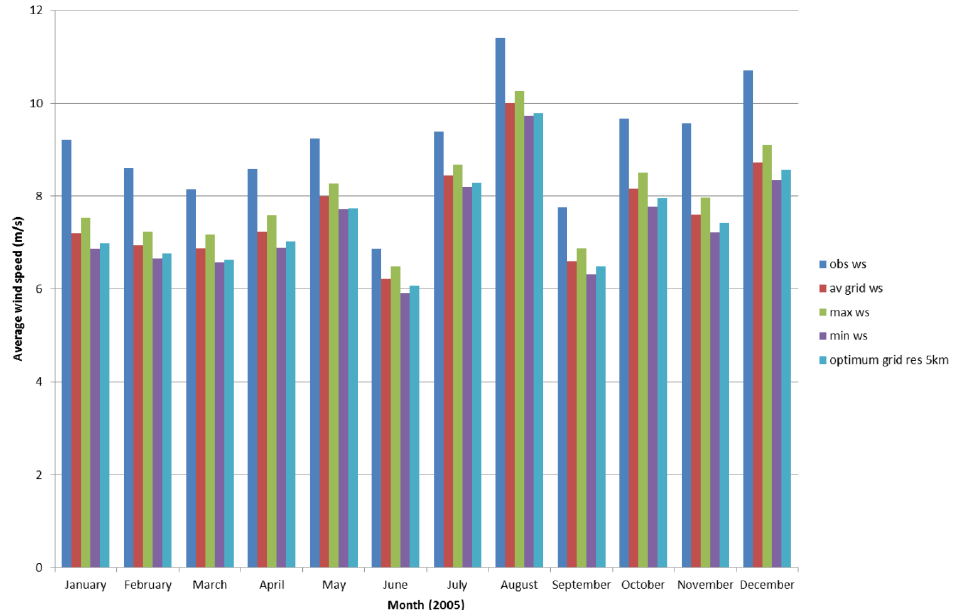
Figure 6. Average wind speed observations for each month of 2005 for the observations, the average of all the grid surrounding grid points, the maximum and minimum wind speed from the surrounding grid points, and the optimum resolution of 5 km found earlier.